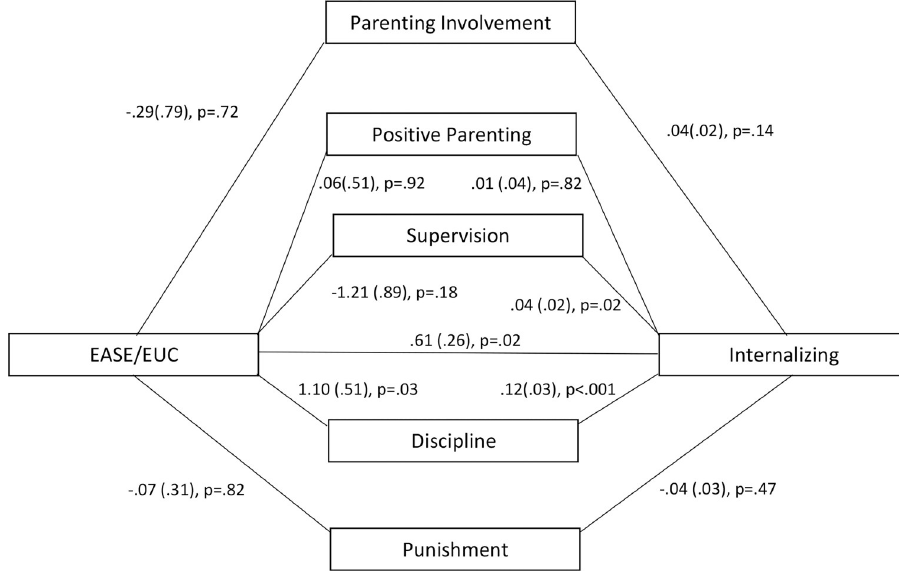
Fig 2. Path model of relationship between intervention, change in parenting style, and change in children’s mental health. Path model demonstrates that for refugees in gPM+, the more disciplinary parenting decreased (as measured by the Alabama Parenting Questionnaire) there was a greater decrease in their children’s and internalising problems (as measured by the Pediatric Symptom Checklist). Values are unstandardized coefficients (standard error). EASE, Early Adolescent Skills for Emotions; EUC, enhanced usual